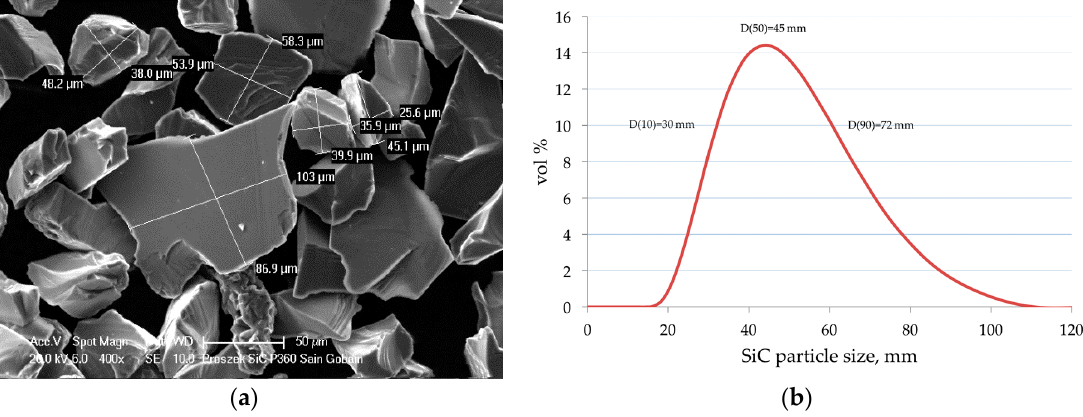
Figure 1. ( a ) SEM image of SiC reinforcement particles; ( b ) particle size distribution.